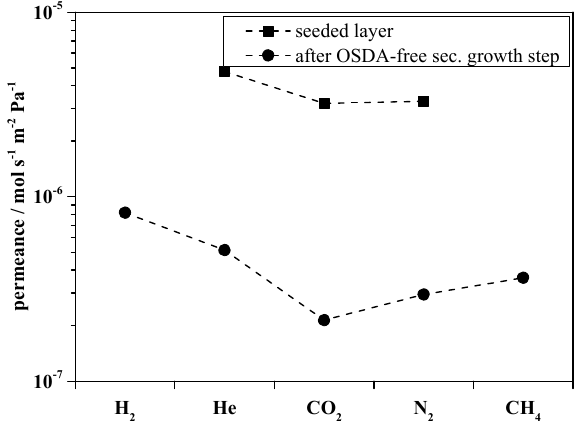
Figure 7. Comparison of the single gas permeance of small gases for the in situ seeded membrane 2.1 (square) and the OSDA-free layer membrane 2.2 (circle).